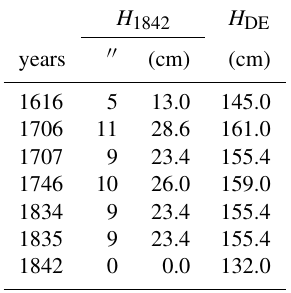
Table 8. Marks on a hunger stone in Pirna surveyed in 1842 (Pro- tokoll,